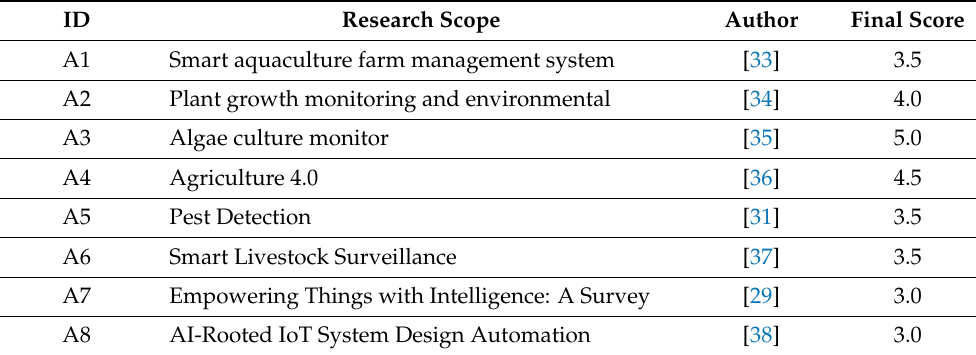
Table 5. Quality